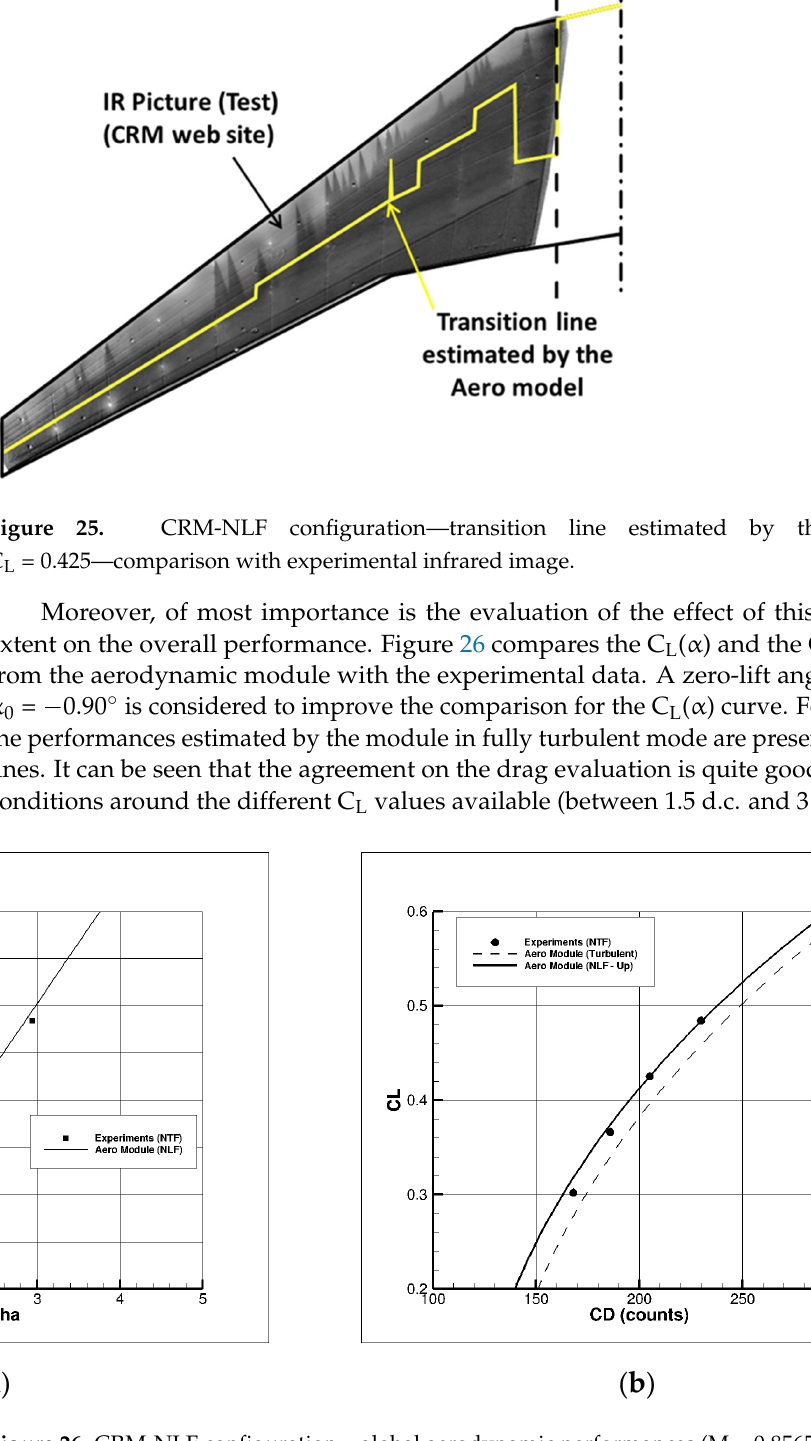
Figure 26. CRM-NLF configuration—global aerodynamic performances (M = 0.8565, Re = 15 × 10 6 ). Lines—aerodynamic module; symbols—experiments. ( a ) C L ( α ). ( b ) C L (C D ).